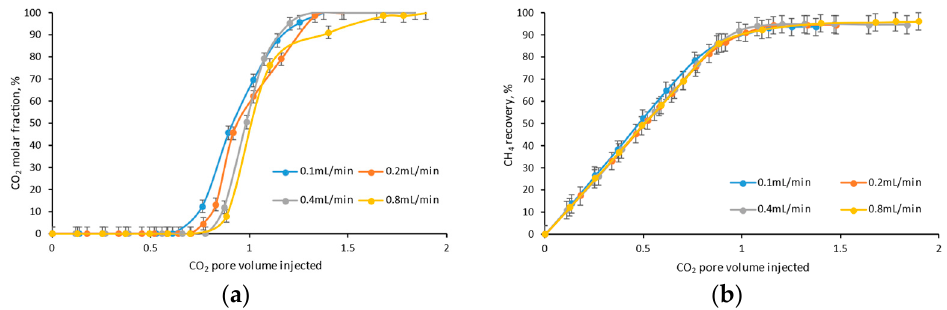
Figure 11. The variation curves under different injection rates. ( a ) CO 2 content at the long core outlet; ( b ) CH 4 recovery.